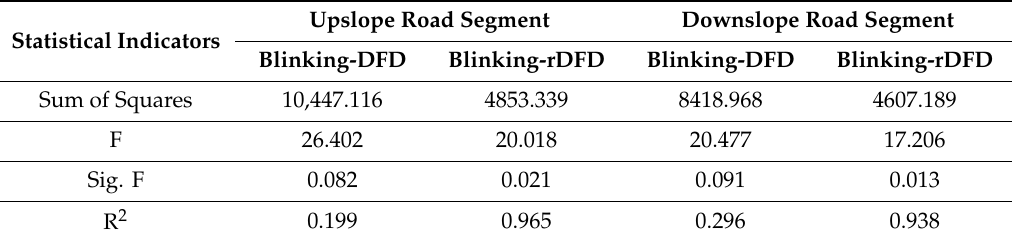
Table 2. Results of F-test between two HRV-based algorithms and blinking frequency-based algorithm.